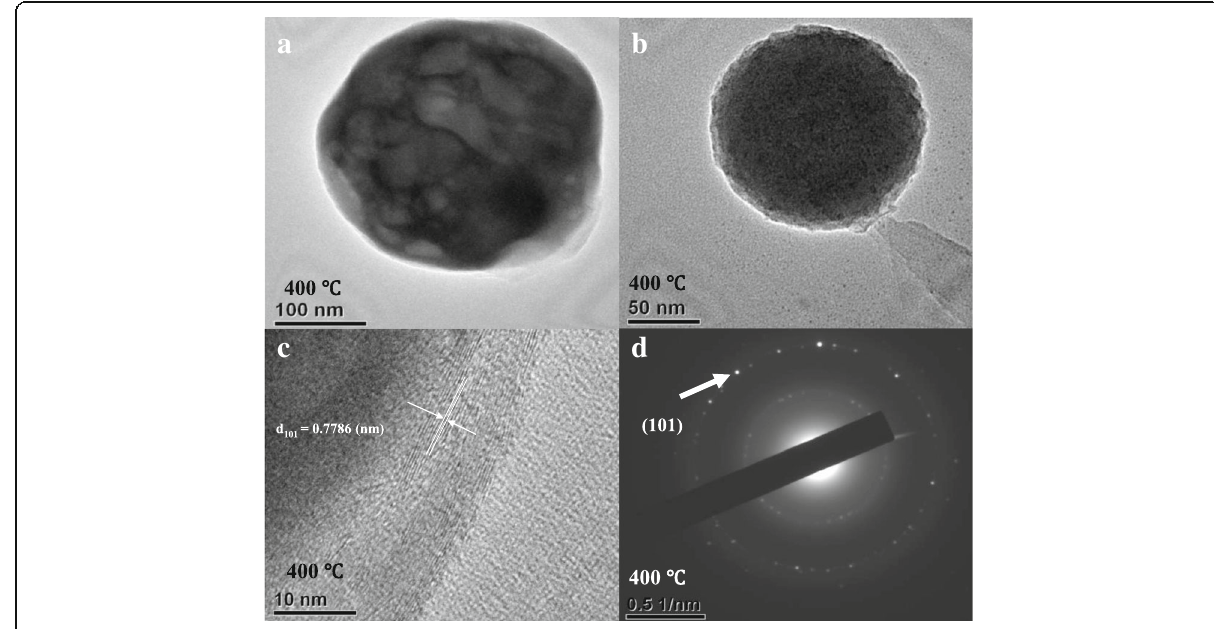
Fig. 5 a – c HR-TEM images of the α -NiS nanosphere. d SAED pattern of the α -NiS nanosphere was annealing at 400 °C for 4